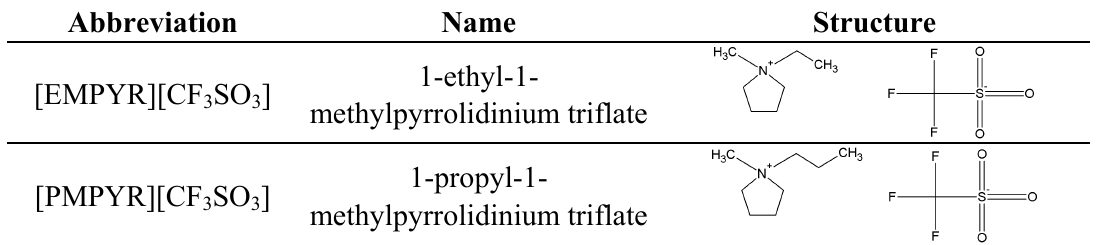
Table 1. Abbreviations, names and structures of investigated ionic liquids.